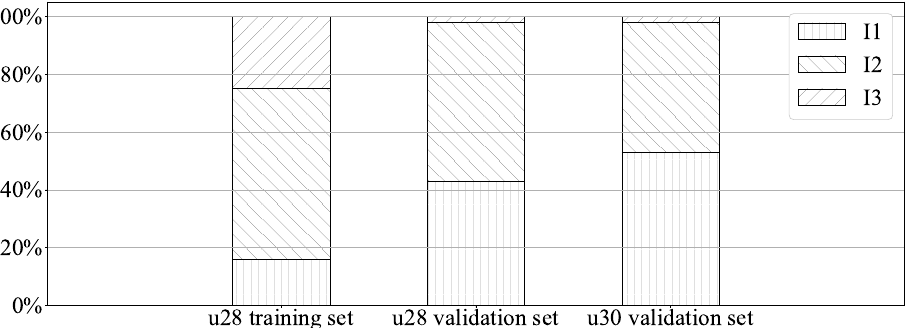
Figure 6. Percentage ratio of the the traces to three intervals of speed limit (km/h): 0 ≤ I1 ≤ 50; 50 < I2 ≤ 100; I3 >